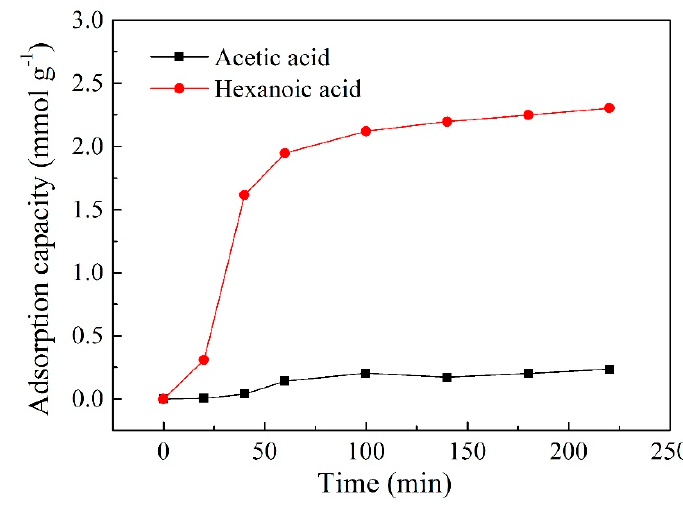
Figure 12. Adsorption capacity of PIM for acetic acid and hexanoic acid (PIMs: PIM4; Feed solution: 0.01 mol L − 1 acetic acid +0.01 mol L − 1 hexanoic acid, pH = 6).